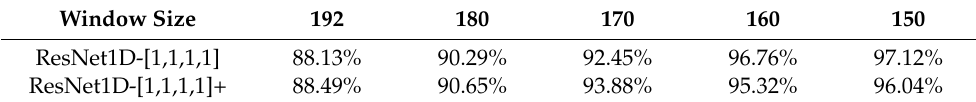
Figure 5. Learning curves and losses of window slicing method when the window size is 180, 170, 160 and 150. The network model is ResNet1D-[1,1,1,1]. Table 2. The accuracy of action recognition when the size of slice window is 192, 180, 170, 160, 150.